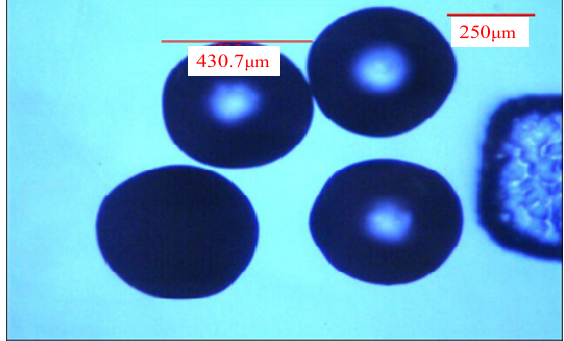
Figure 5. Microcapsules of alginate/tea tree essential oil.